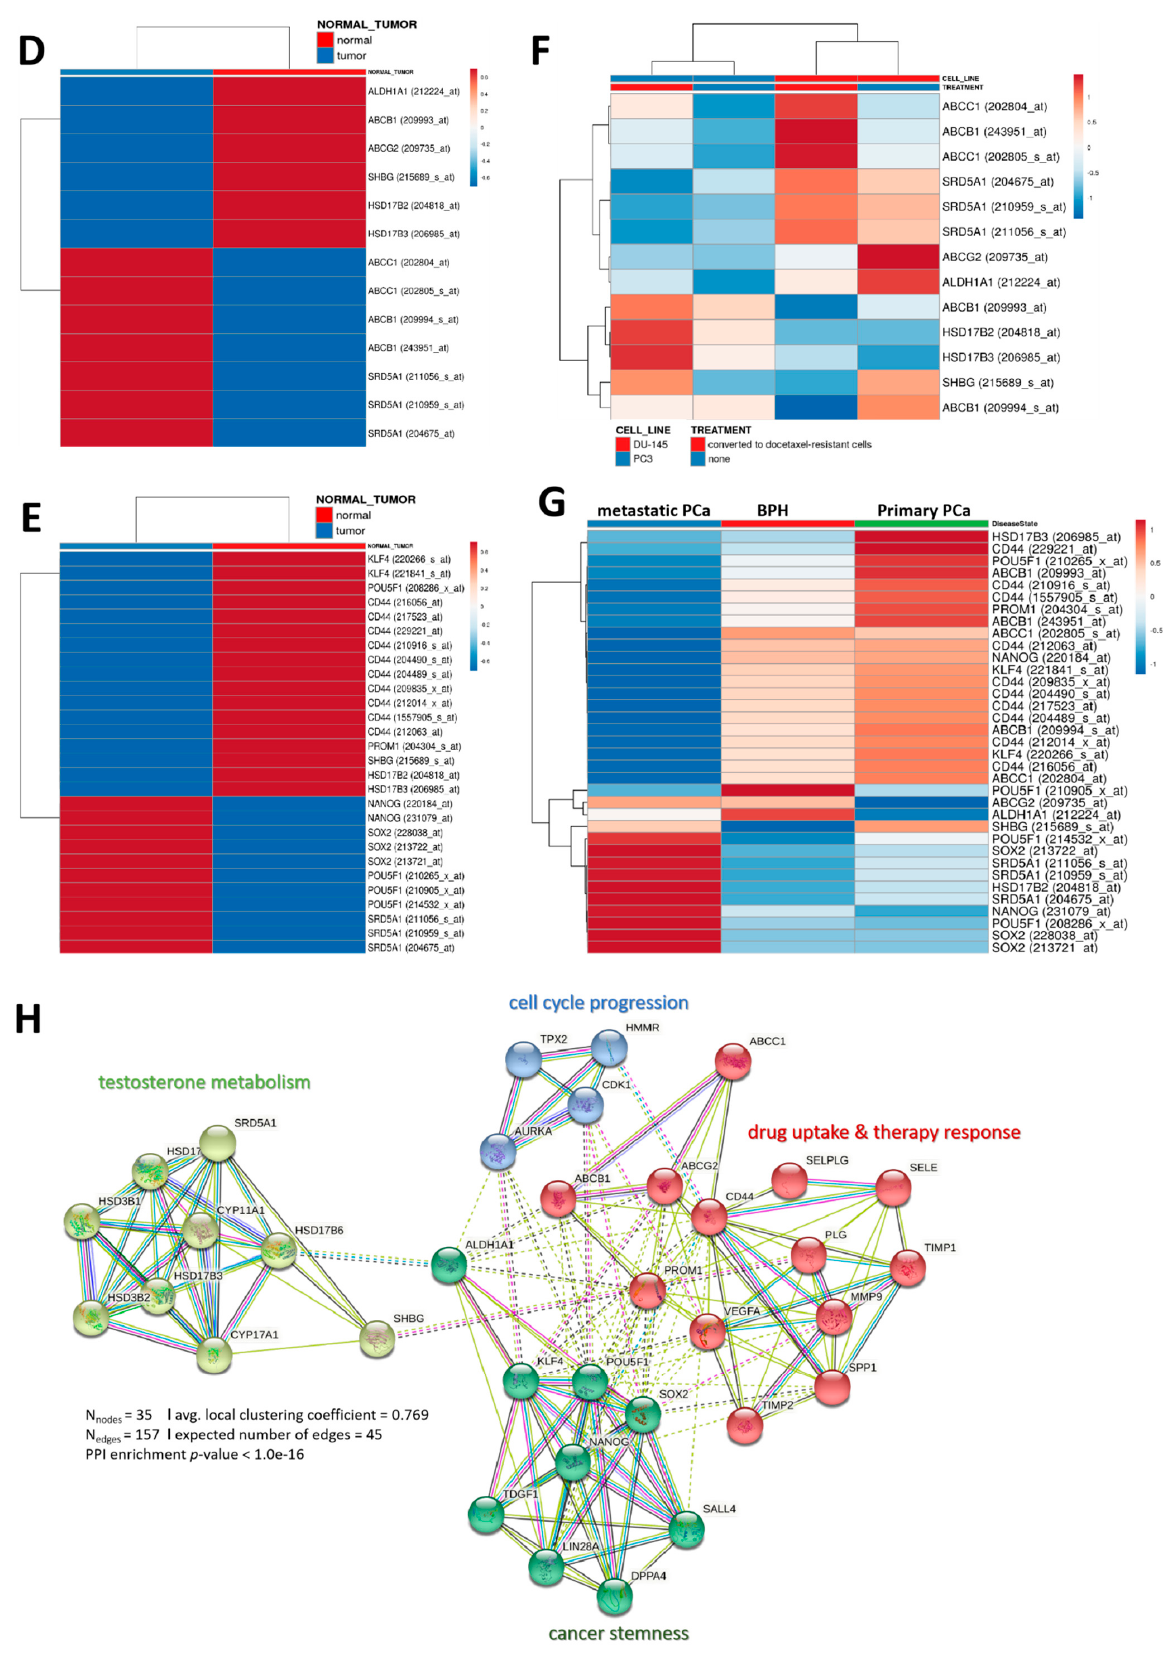
Figure 4. Distinct interaction between the testosterone tetrad elicits androgenic signals that drive cell cycle progression, enhanced motility, cancer stemness, and resistance to therapy in patients with PCa. STRINGdb-generated visualization